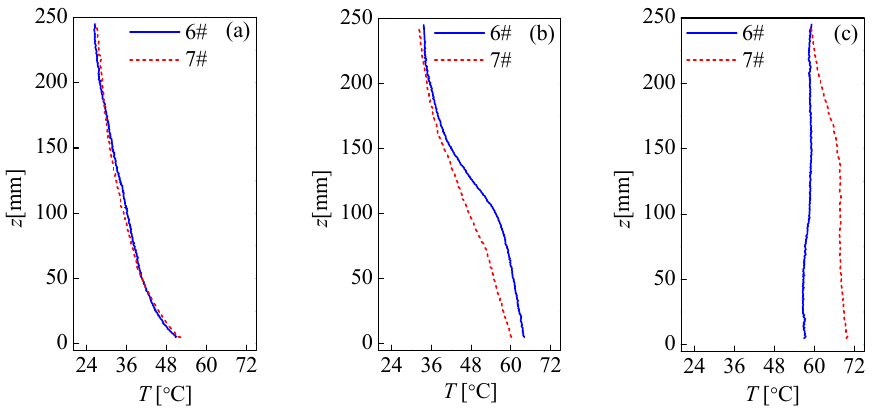
Figure 3. Vertical temperature distribution of condenser under different quasi ‐ steady operation states corresponding to Figure 2c (6# ‐ 7# U ‐ turn): ( a ) small oscillation ( Q = 30 W); ( b ) big oscillation ( Q = 70 W); and ( c ) circulation ( Q = 140 W).